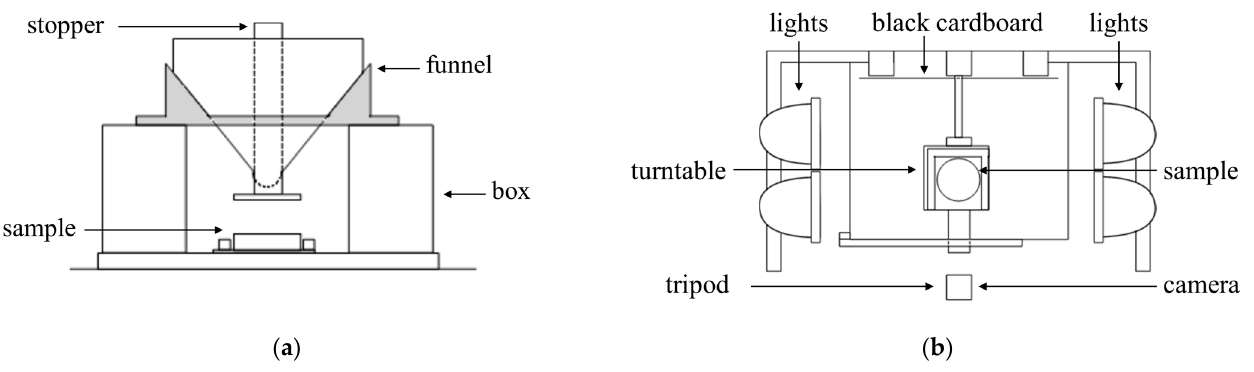
Figure 2. ( a ) The diagram of the milk powder delivery device; ( b ) A plan view of the photogram ‐ metry equipment and sample stage.